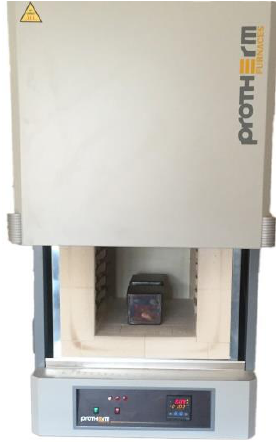
Figure 1. Heat treatment furnace where boriding process is performed.